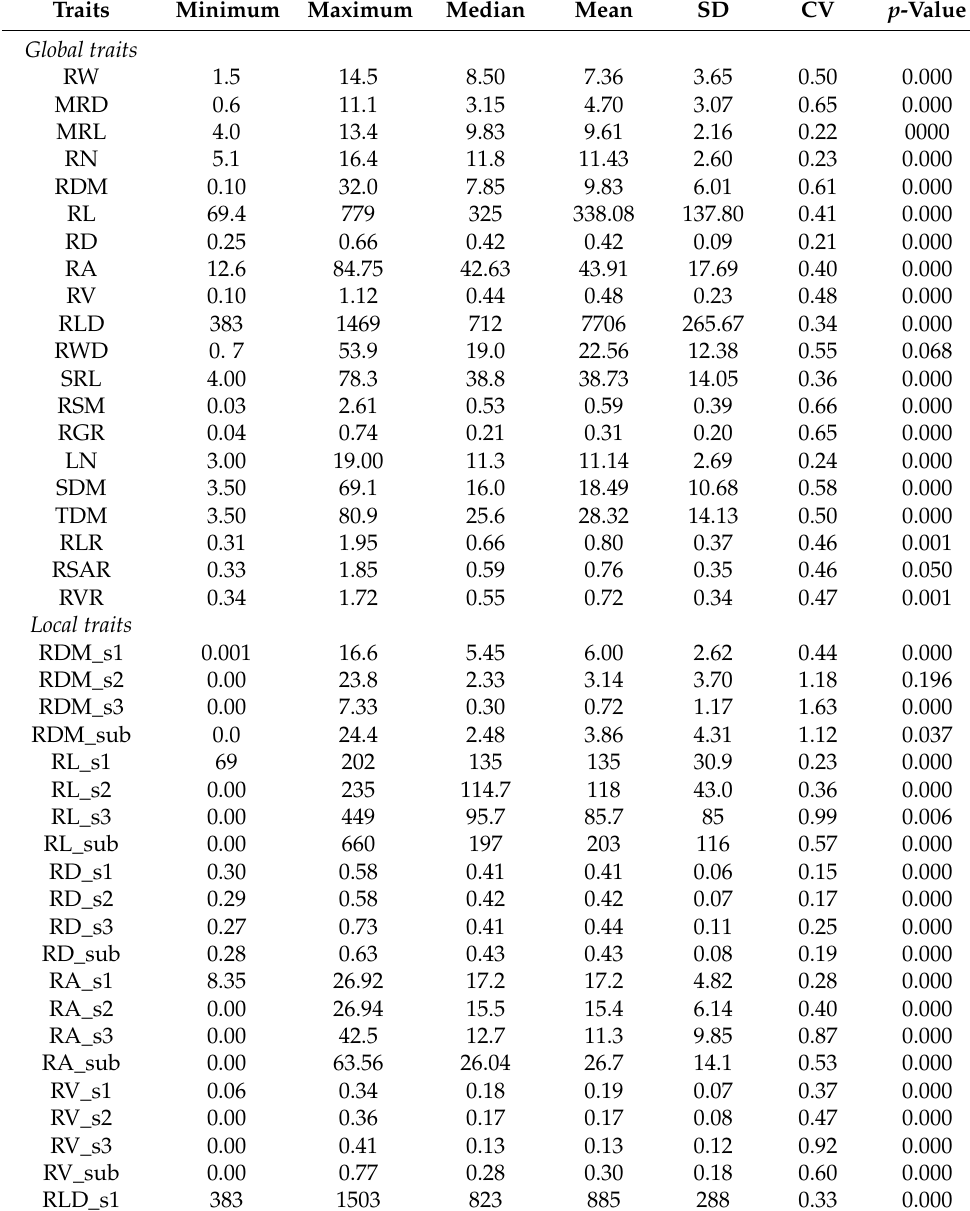
Table 2. Minimum, maximum, mean, medium, standard deviation (SD); coefficient of variations (CV); and p -value of global and local traits in 65 millet